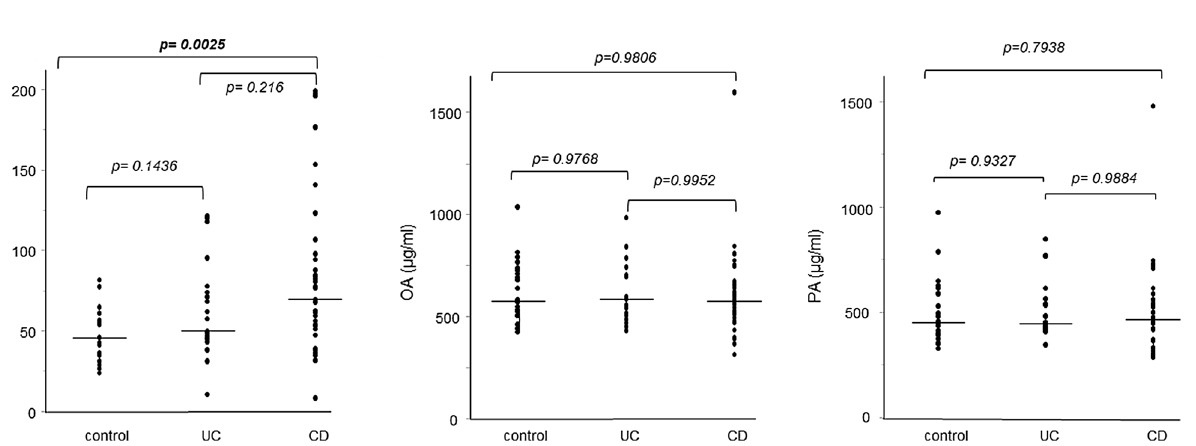
Figure 1. Elevation of serum palmitoleic acid (PO) levels in the serum of patients with Crohn’s disease (CD). Serum PO, oleic acid (OA), and palmitic acid (PA) levels were compared between patients with CD and healthy controls (control). The p-values in the graph show significant differences determined using the Steel–Dwass